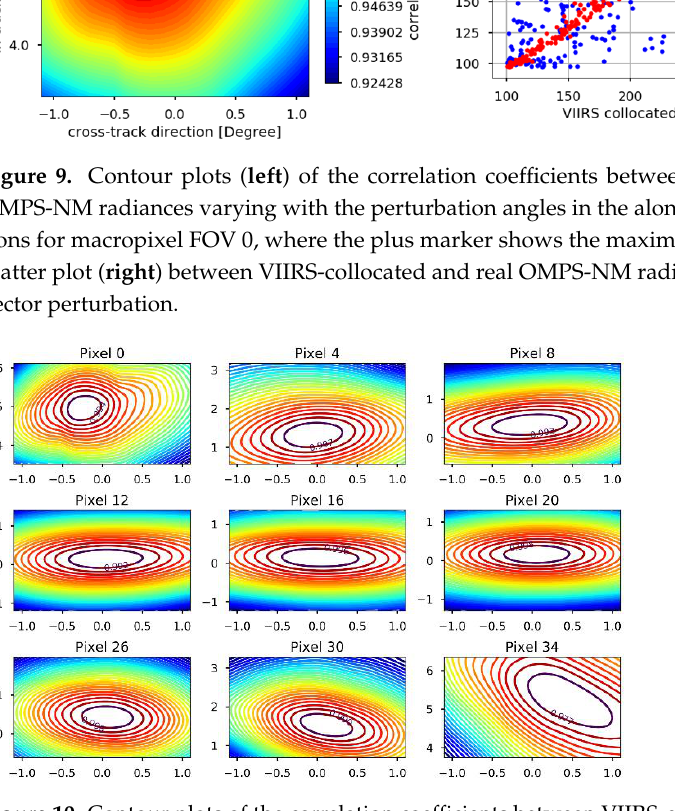
Figure 10. Contour plots of the correlation coefficients between VIIRS-collocated and real OMPS-NM radiances varying with the perturbation angles in the along-track and cross-track directions at the nine (9) macropixel FOV positions, where the angle values with the maximum correlation are used to estimate the geolocation error of OMPS-NM.